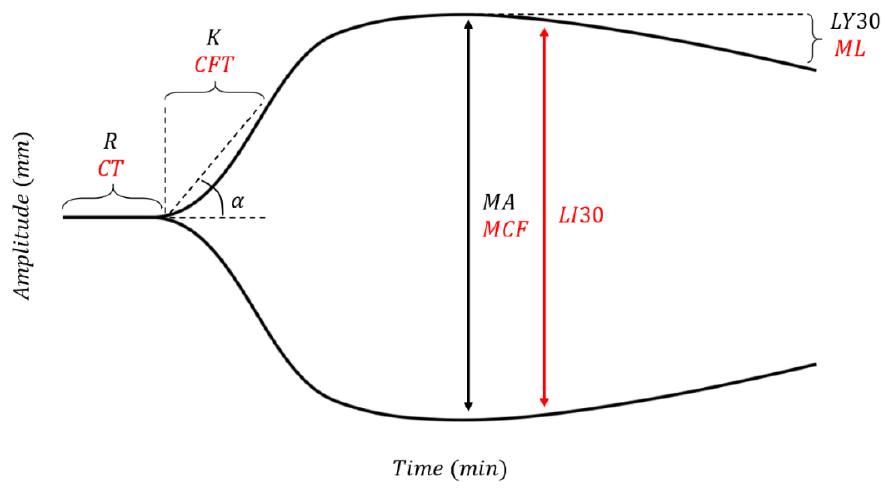
Figure 2. A typical graphical output of TEG ® (parameters shown in black) and ROTEM ® (parameters shown in red). R (Reaction Time)/CT (Clotting Time) denotes the time taken for blood to begin initiation of enzymatic clotting factor activation (marked by a movement of 2 mm along the y -axis). K/CFT (Clot Formation Time) denotes the time taken for movement of the pin by 20 mm along the y -axis. The α -angle is software-calculated using the slope of the secant line from the split point of the curve to K [111]. Clot kinetics are typically determined by K and α -angle, which together describe clot-strengthening rate and the cleavage of fibrinogen to fibrin by thrombin. Maximum Amplitude (MA) or Maximum Clot Firmness (MCF) denotes the peak of the curve and the point of greatest platelet-fibrin interaction [105,107]. Lysis at 30 min (LY30) is measured 30 min after MA as a percentage dissolution from MA peak. LI30 (Lysis Index at 30min) is measured as the amplitude 30 min after CT. Maximum Lysis (ML) is expressed as a percentage dissolution from MCF peak at the time of evaluation during the performance of the test and is roughly equivalent to the LY30 [43,106–108,112].